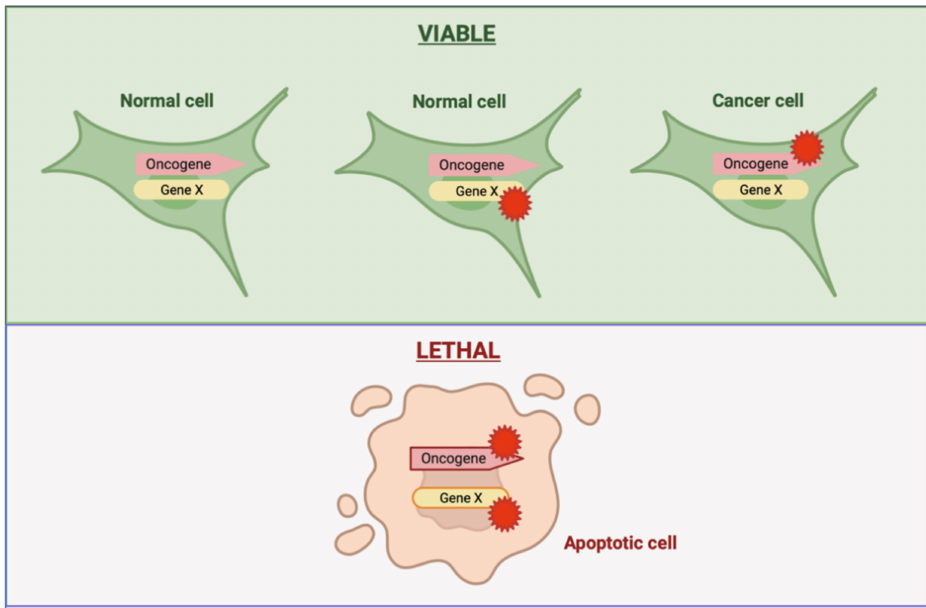
Figure 2. Synthetic lethality as a therapeutic strategy in cancers driven by oncogenes. Synthetic lethality happens when the alteration of an oncogene or gene X in isolation is compatible with